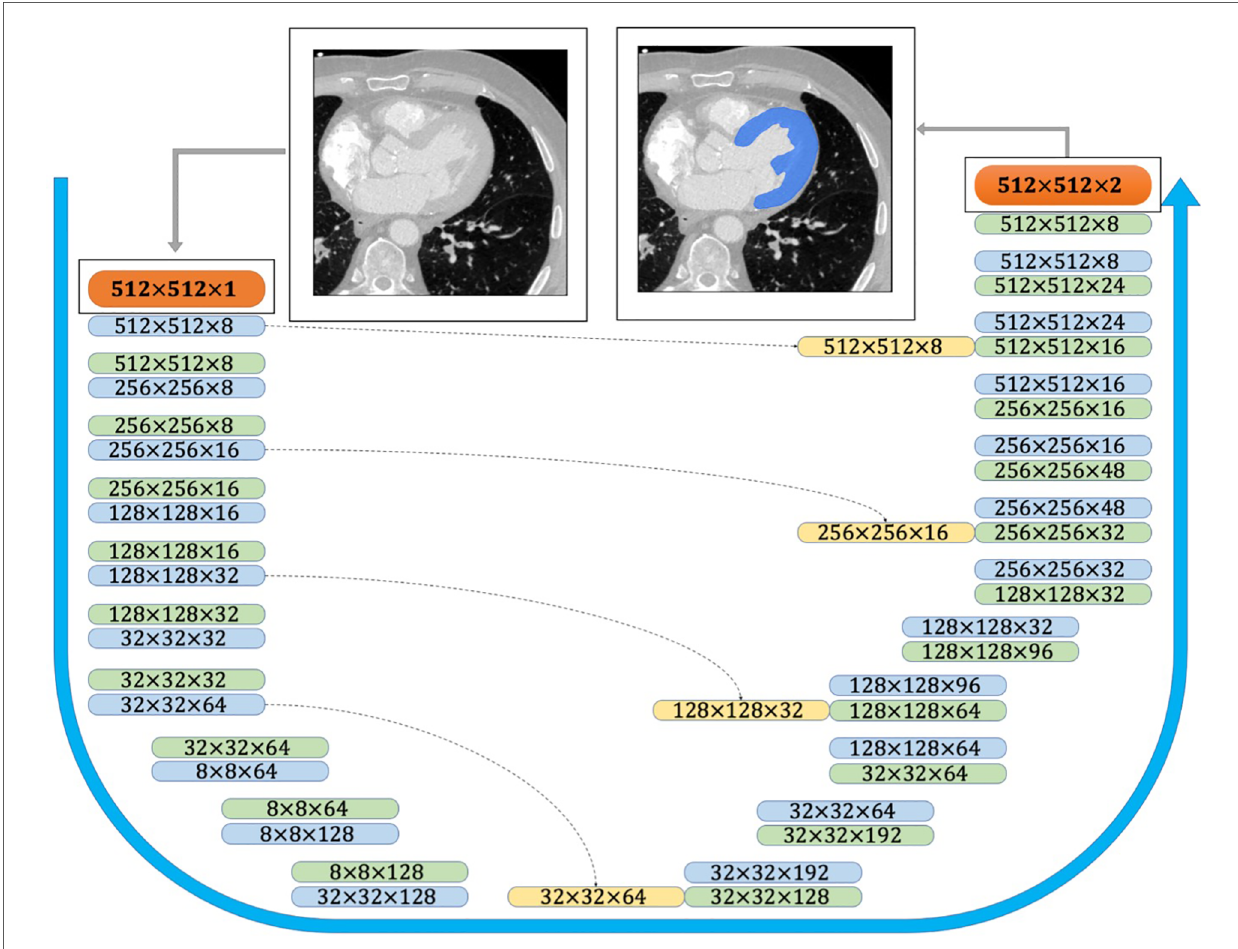
FIGURE 3 CNN architecture used for semantic image segmentation. The input and output images are shown as orange boxes. The inputs and outputs of the CNN layers are shown as green and blue boxes, respectively. The yellow boxes represent the copied tensors, and the blue arrow indicates the fl ow of the CNN model from raw input image to the binary segmented output